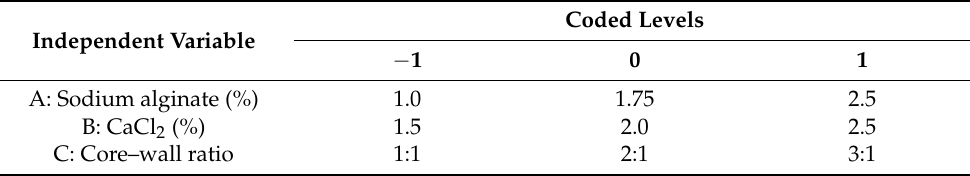
Table 1. Coded and actual values for Box–Behnken Design (BBD).